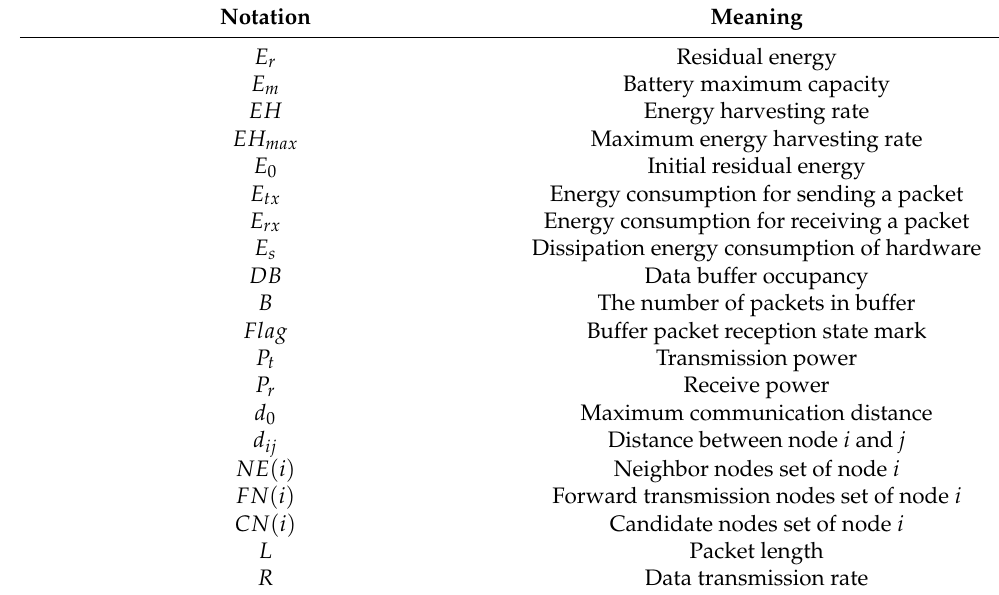
Table 1. The list of core notations related to the system